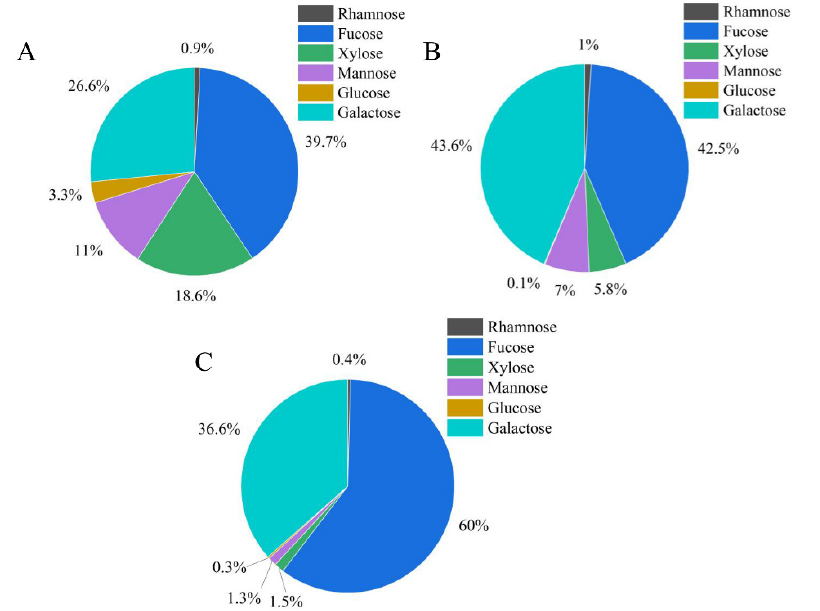
Figure 3. Monosaccharide composition of ZF1, ZF2, and ZF3. ( A ) Monosaccharide composition of ZF1; ( B ) monosaccharide composition of ZF2; and ( C ) monosaccharide composition of ZF3.